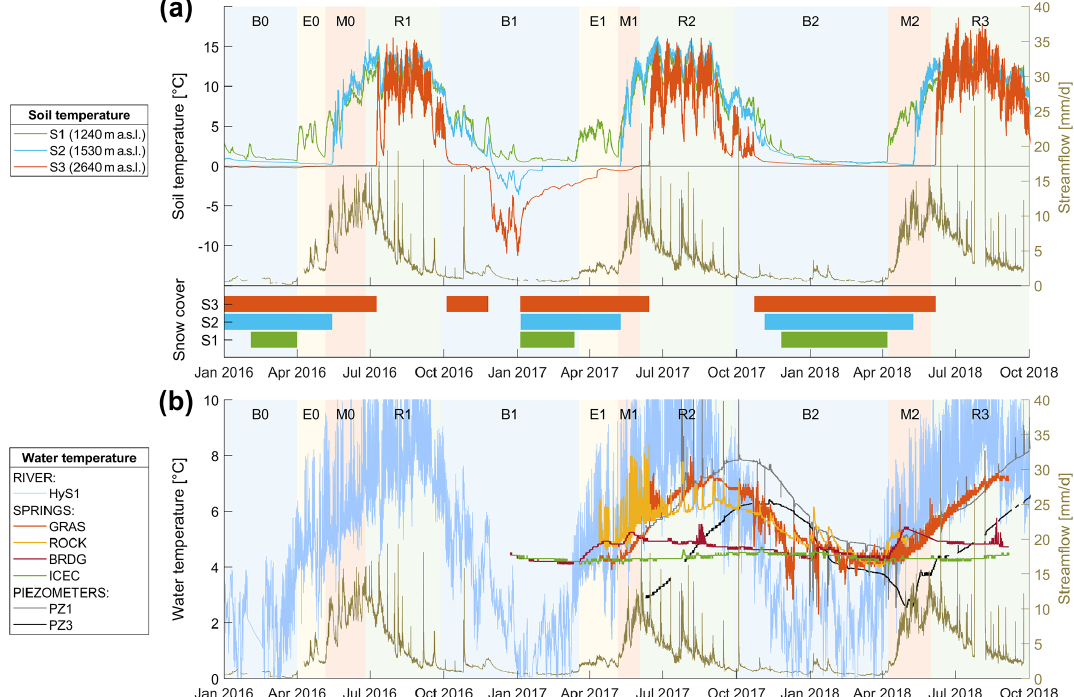
Figure 3. Evolution of soil temperature (a) at three locations within the Vallon de Nant catchment (S1, S2, and S3) and (b) at the stream at the outlet (HyS1), four springs (GRAS, ROCK, BRDG, and ICEC), and groundwater at two locations (PZ1 and PZ3) between January 2016 and October 2018. A summary of the dates corresponding to the 11 runoff periods divided by baseflow (B0, B1, and B2), early melt (E0 and E1), melt (M0, M1, and M2), and recession (R1, R2, and R3) is available in the Supplement (Table